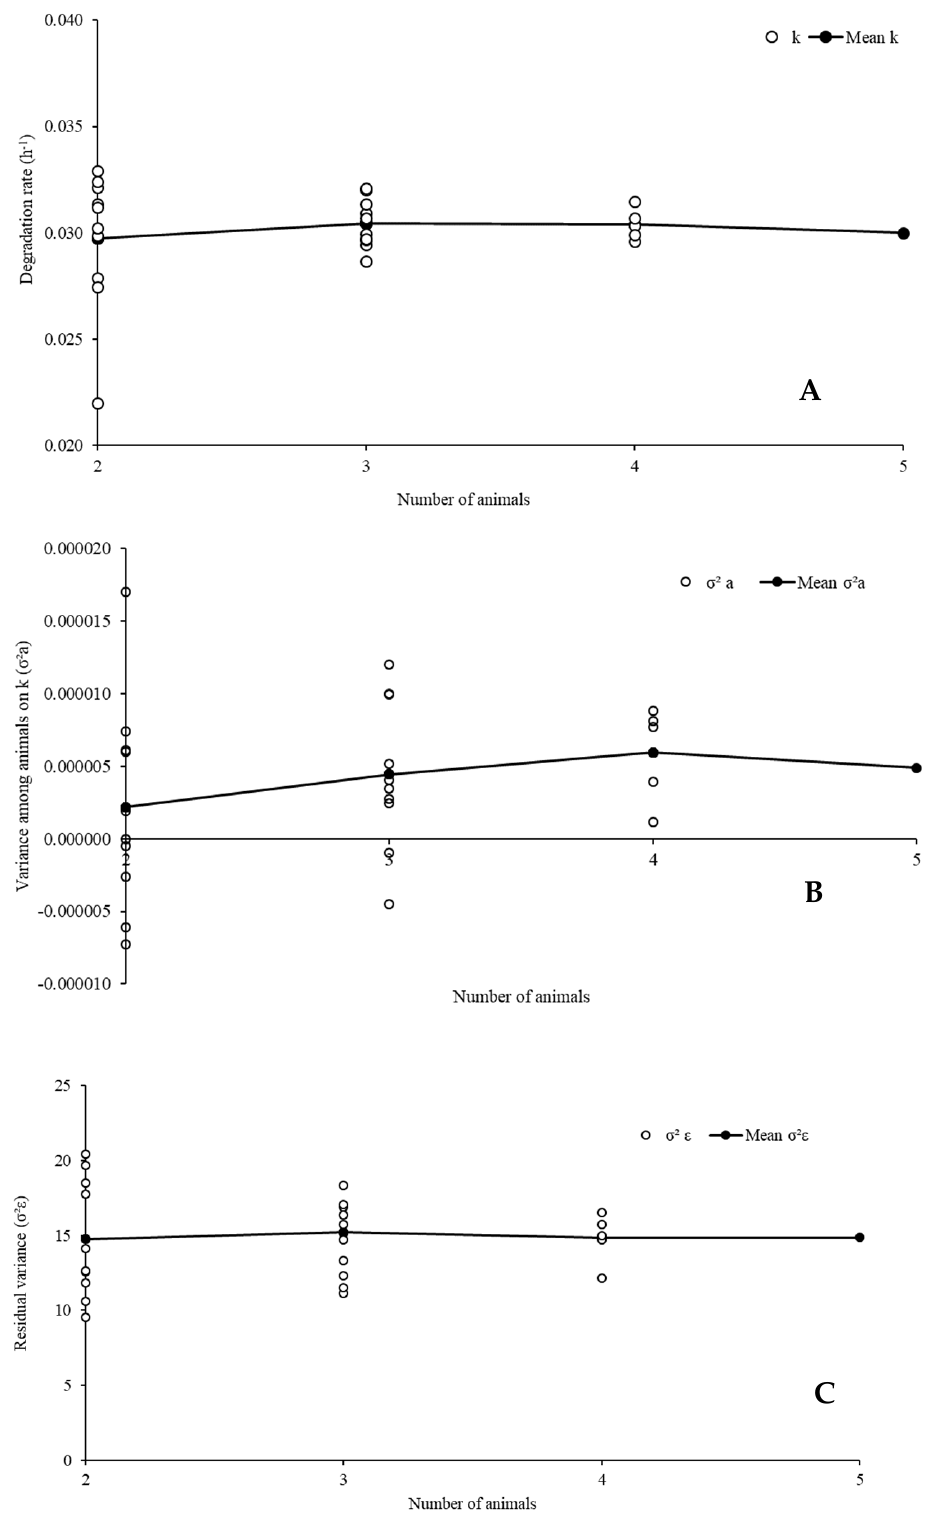
Figure 4. Variability of the estimates of degradation rate of the potentially degradable insoluble fraction of the dry matter (k), ( A ), random variance among animals on k ( σ 2 a ), ( B ), and residual variance ( σ 2 ε ), ( C ) for the dry matter degradation profile of cottonseed meal according to the number of animals used in the in situ trial.